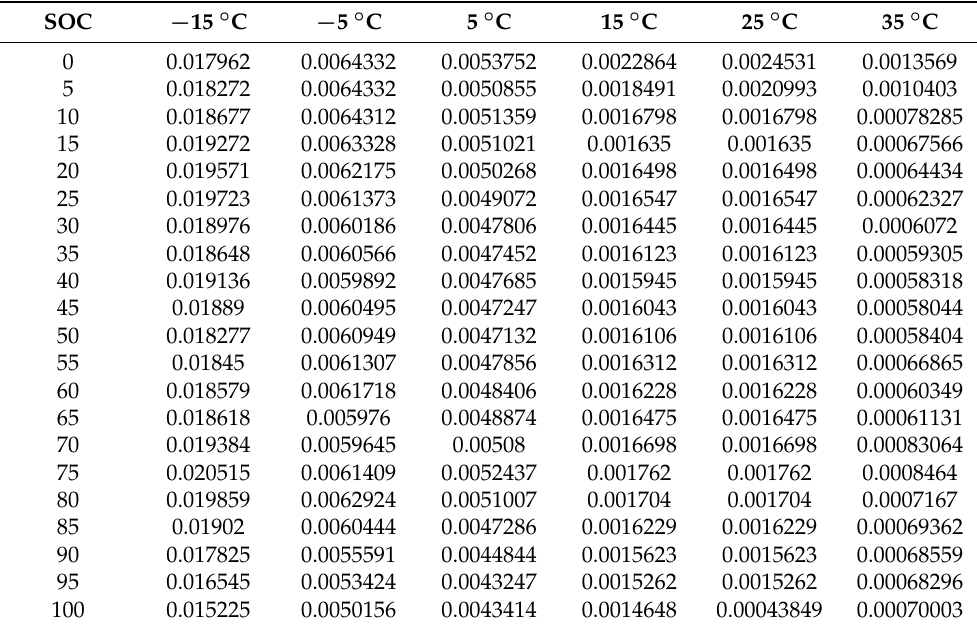
Table A4. Values for parameter R 2 in Ω of electrical model shown in Figure 2 in dependence of cell temperature and SOC.